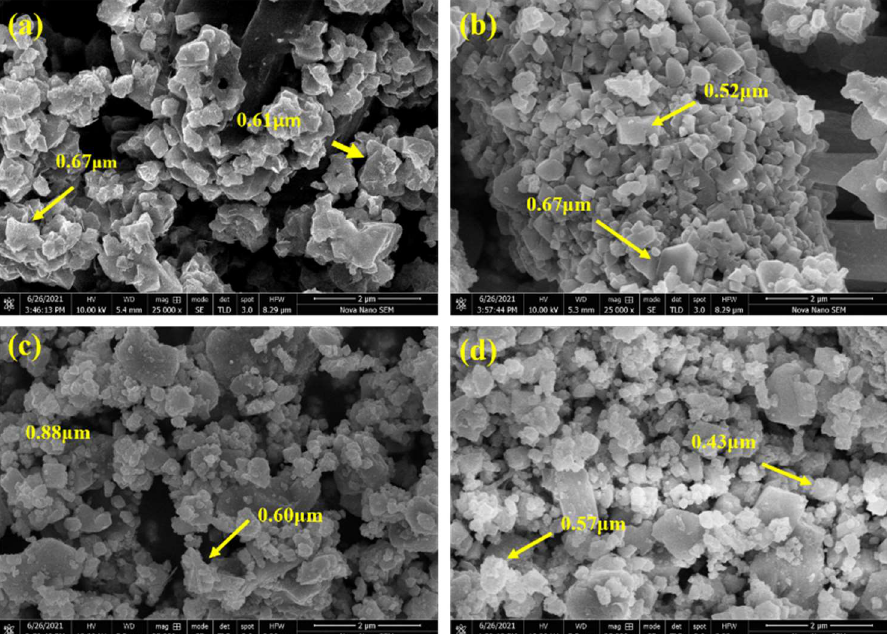
Figure 4. SEM micrograph of pristine UT40, UT45 4 ( a, c ), and plasma-treated PT40, PT45 4 ( b, d ) specimens.